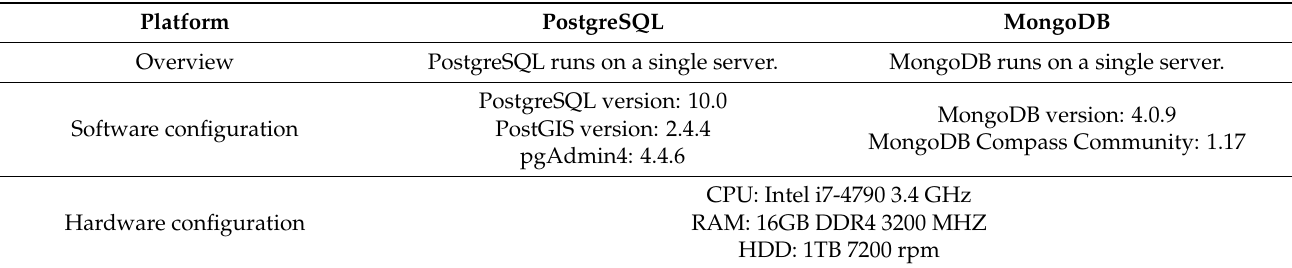
Table 1. Descriptions of testing platforms.